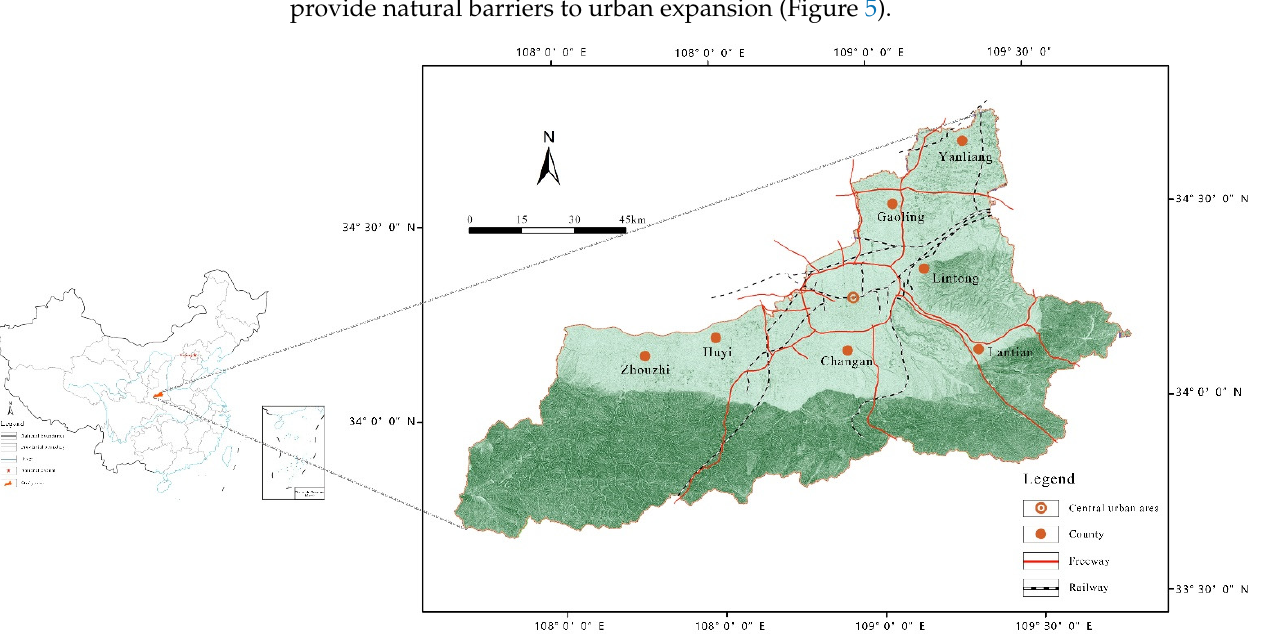
Figure 5. The research